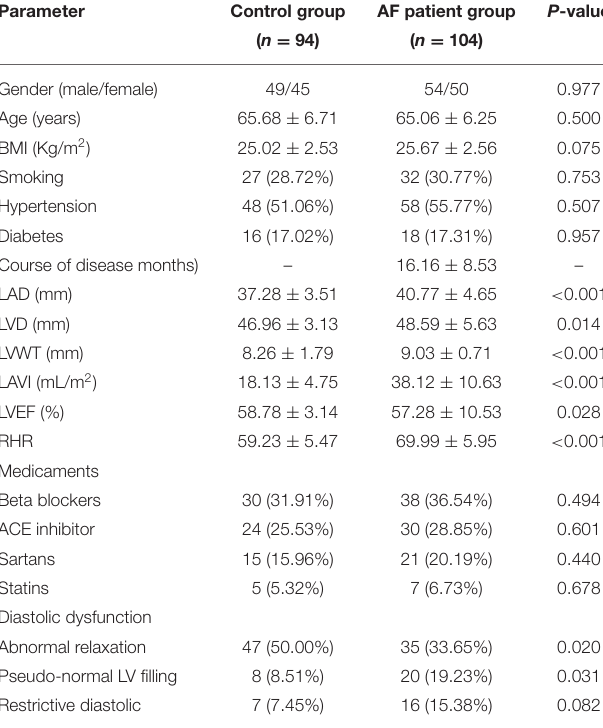
TABLE 1 | Clinical data of the study